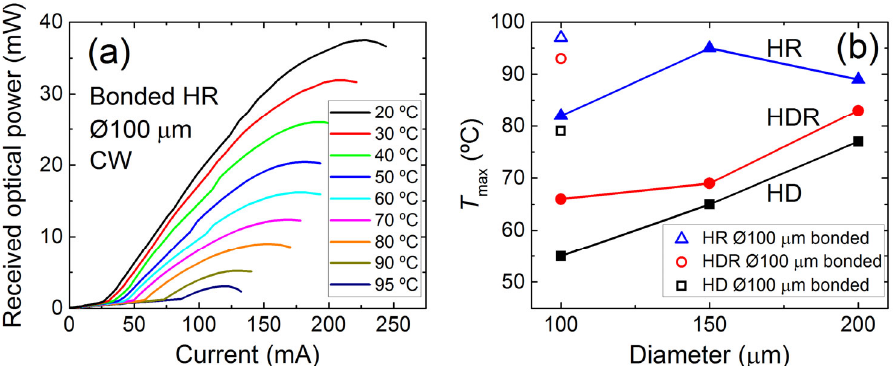
Figure 8. ( a ) The light-current curves of a Ø100 µ m HR bonded onto a Si-board at various temper- atures measured in a CW pumping regime. ( b ) The maximal operation temperature T max of the non-bonded (p-side up mounted) and bonded microlasers versus device diameter.